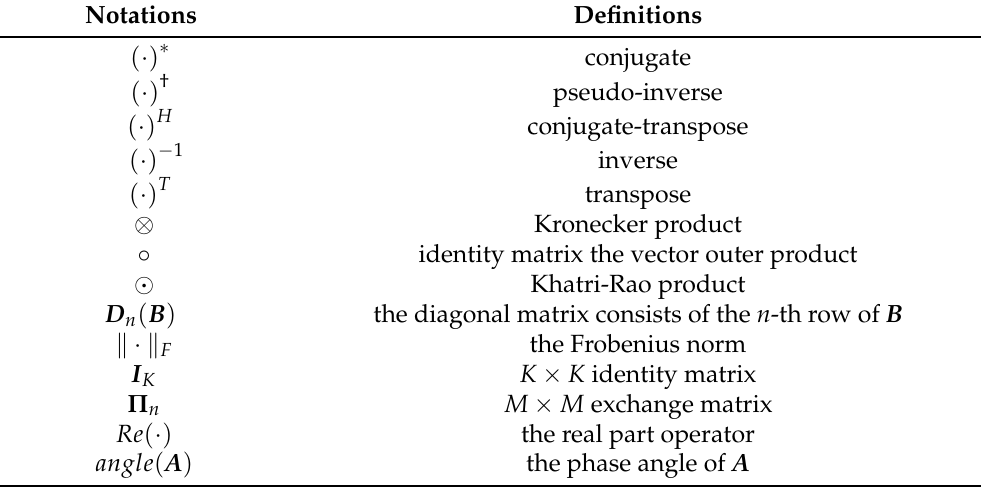
Table 1. Notation of this